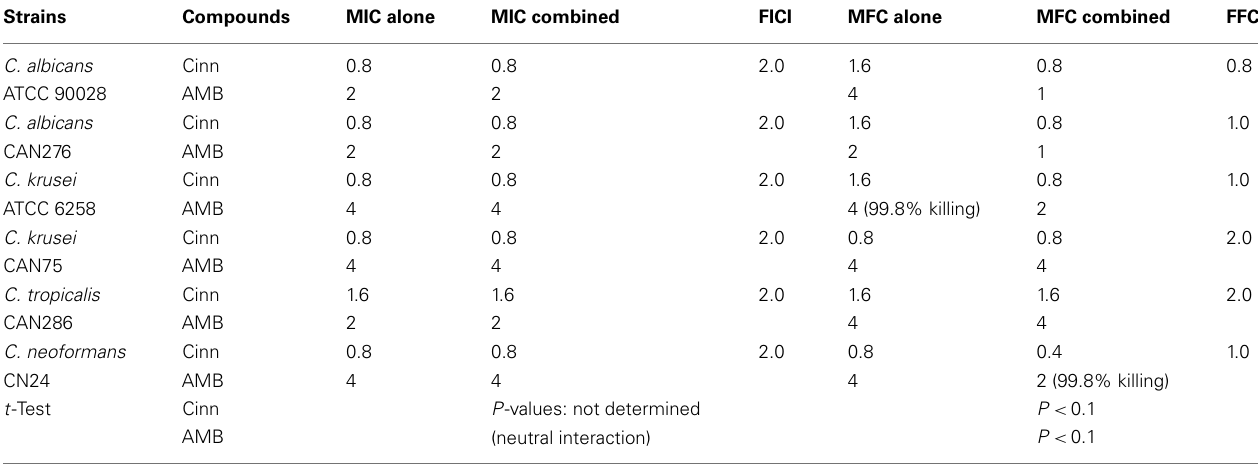
Table 3 | Chemosensitization ofAMB by